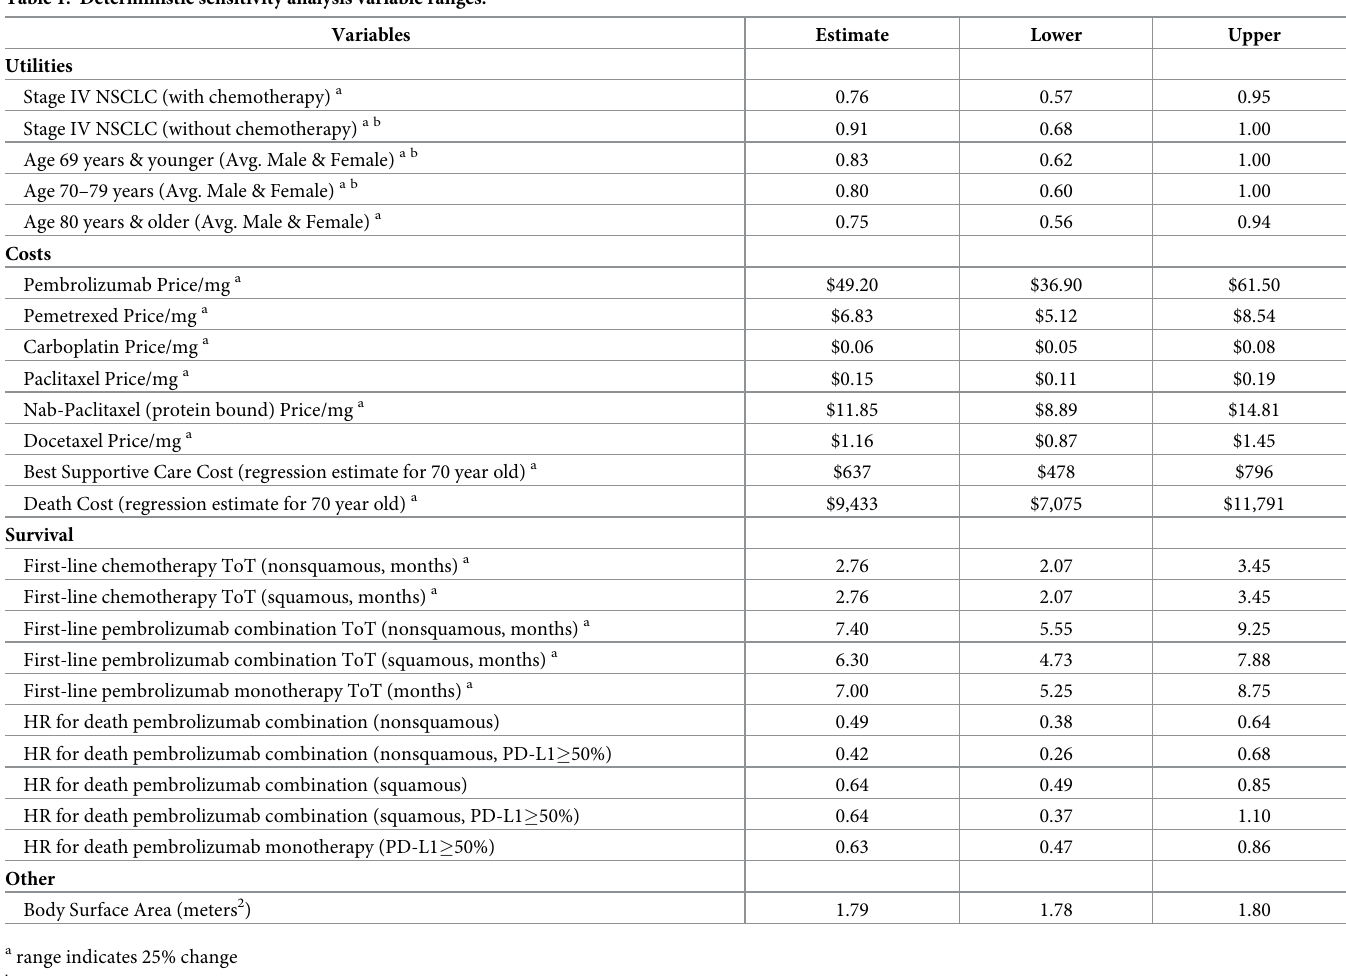
Table 1. Deterministic sensitivity analysis variable